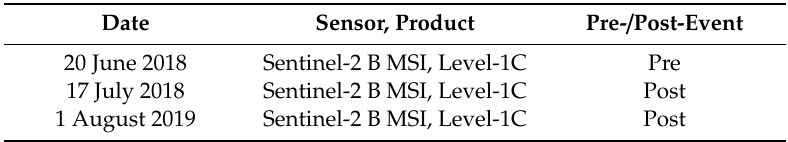
Table 1. Sentinel-2 datasets used in this research. MSI stands for Multispectral